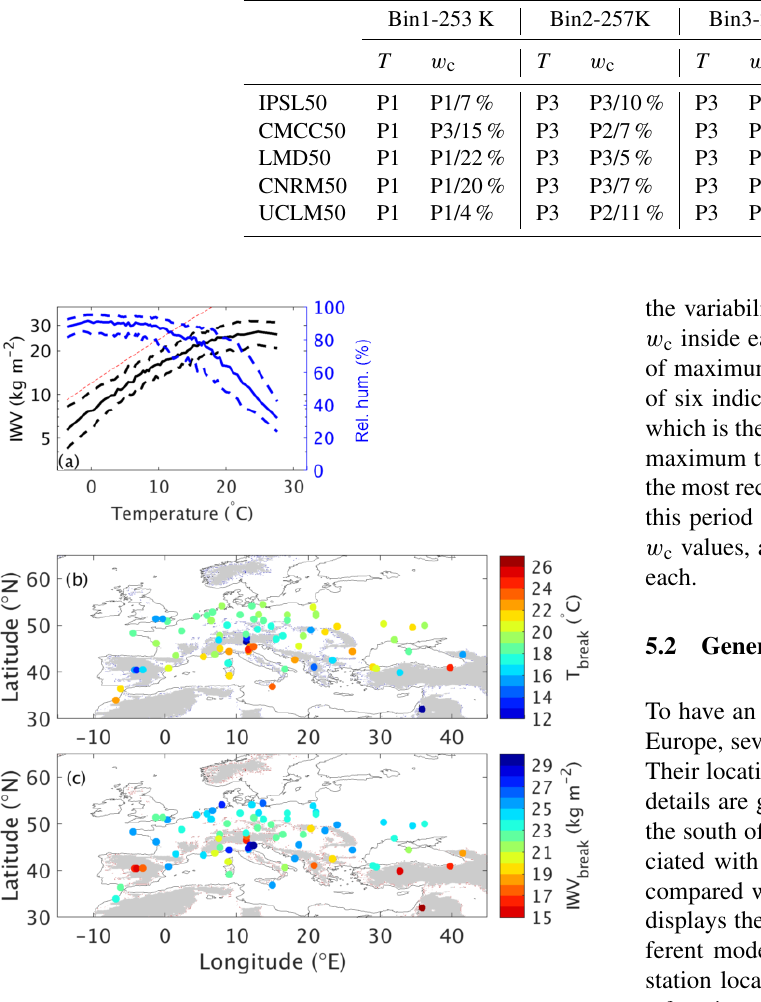
Figure 6. (a) Scaling of IWV (black) and RH (blue) with temper- ature for the model ensemble at SIRTA station. Solid lines are for quantile 50 and dashed lines are for quantiles 20 and 80 of the dis- tributions. The red slant dashed line shows C-C scaling. Panels (b) and (c) are as in Fig. 5c, d but for the model